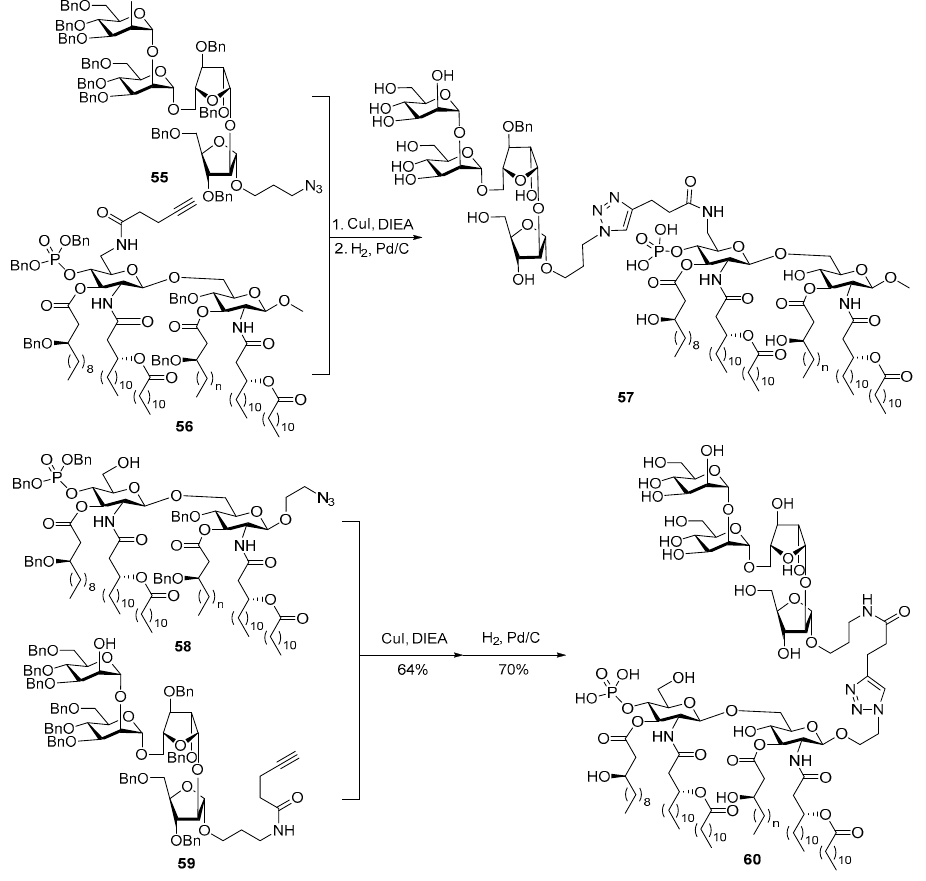
Figure 3. Conjugates of N. meningitidis MPLA with polysialic acids as group C meningitis vaccine